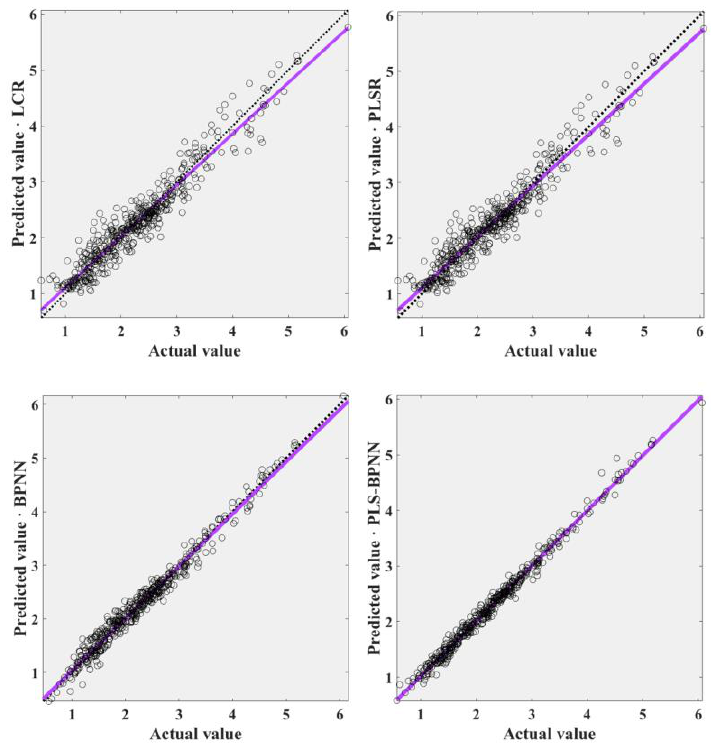
Figure 9. Scatter plot of fitting results of each model.